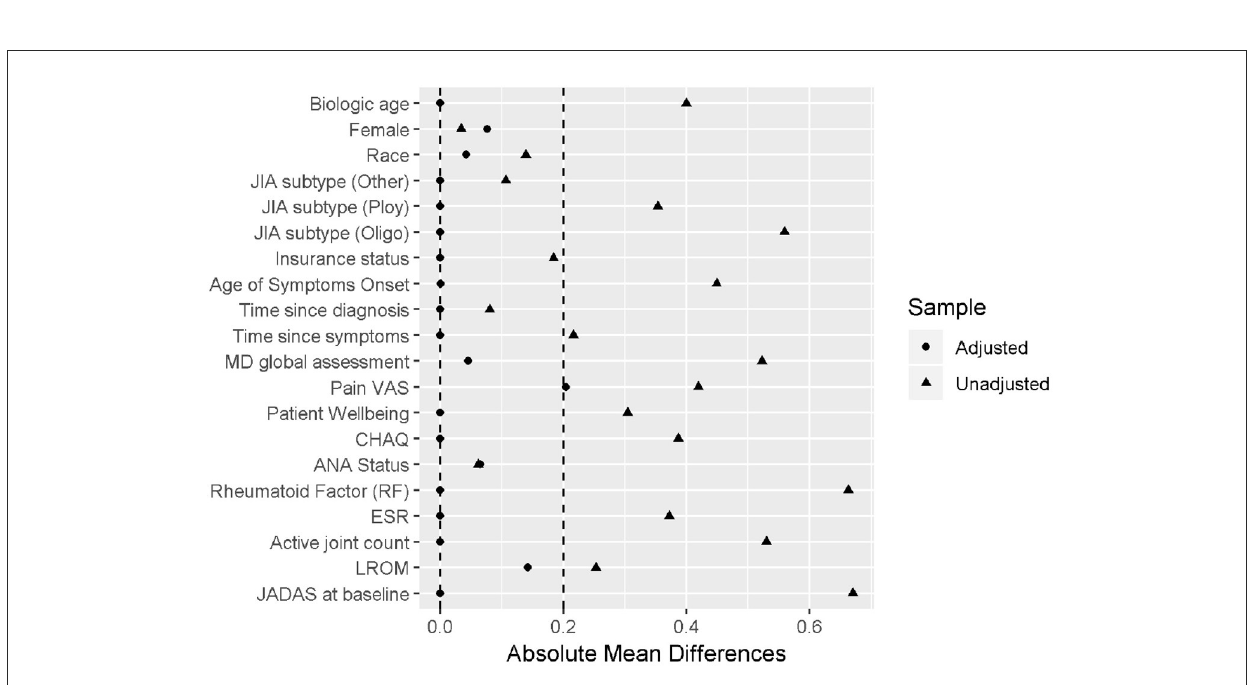
FIGURE6 Balance check results for the cases